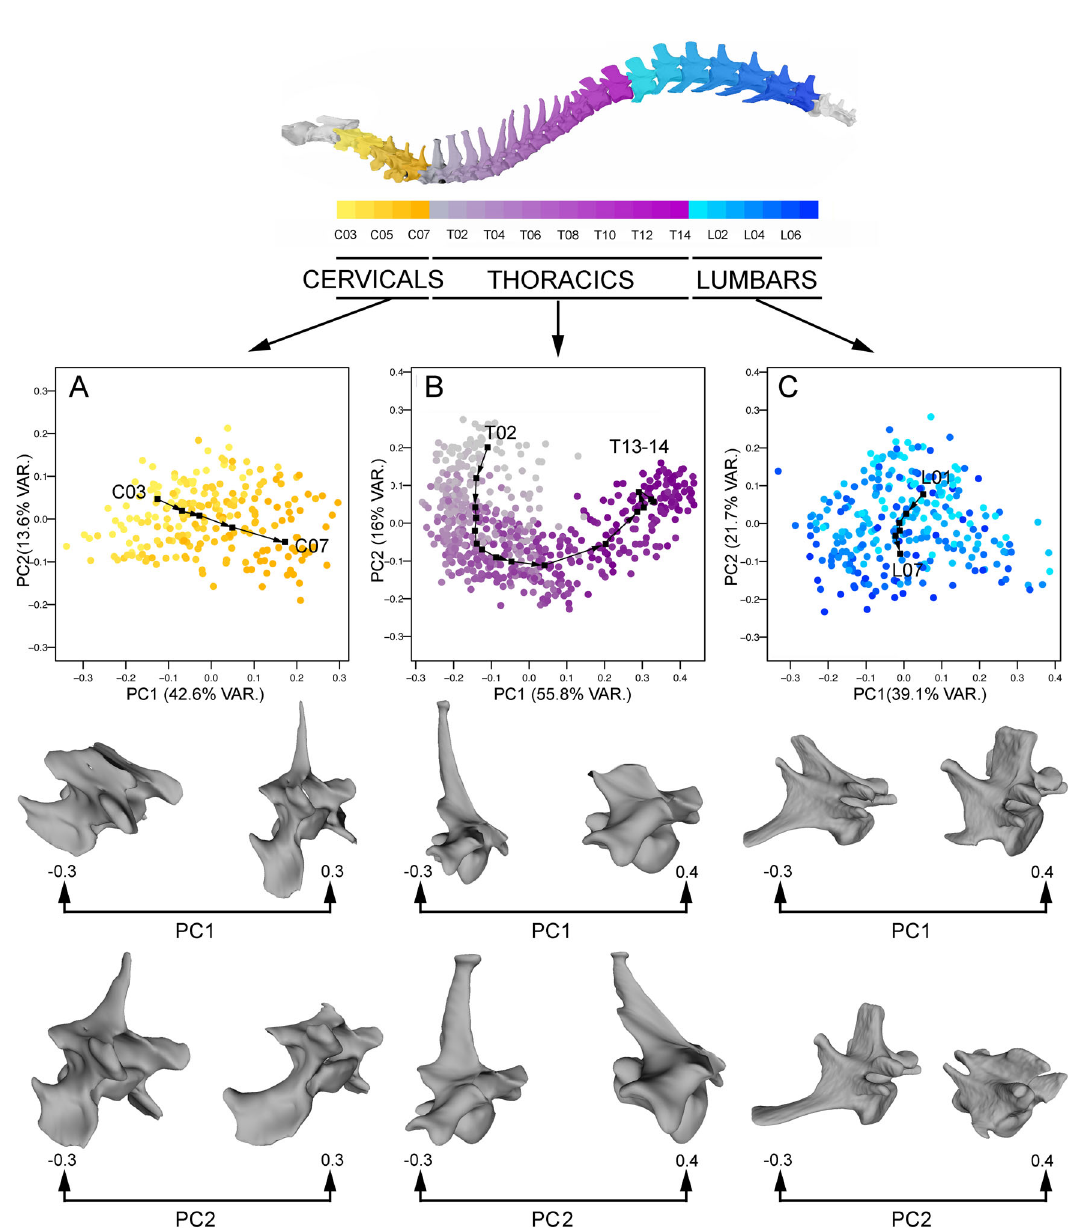
Fig. 2 Results obtained from Principal Components analyses. Morphospace depicted by the bivariate graph of PC1 vs PC2 for the cervical ( A ), thoracic ( B ) and lumbar ( C ) regions. The 3D models showing the morphological changes associated with PC1 and PC2 at the extremes of each axis are shown for the three analyses. Black arrows represent the mean shape for each